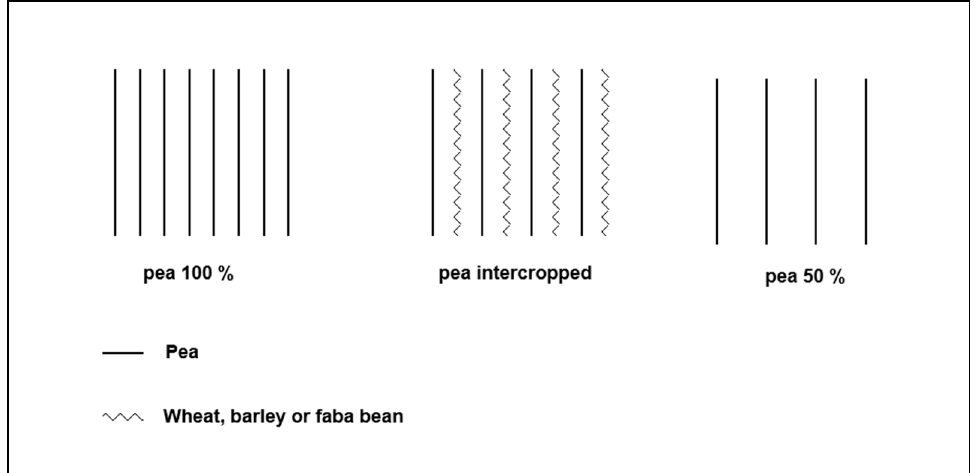
Figure 1. Experimental design for the intercropping experiments. Crop height was assessed at full maturity of crops in trials Cord1-18(i), Alm1-19(i) and Cord2-19(i). Five plants of each crop per plot were measured from the ground to the top of plants, not stretching them, with the help of a ruler. Differences between the height of the companion crops and of pea in the intercropped plots were then calculated. The two central rows of each crop in each plot were harvested. Plants were dried in an oven at 60 ◦ C for 3 days, and then plant biomass was assessed by weighing dry plants from each row. After this, plants were threshed and seeds were weighed. Biomass data were available for trials Alm1-19(i), Cord1-19(i) and Cord2-19(i), and grain yield data were available for trials Alm1-19(i) and Cord2-19(i).